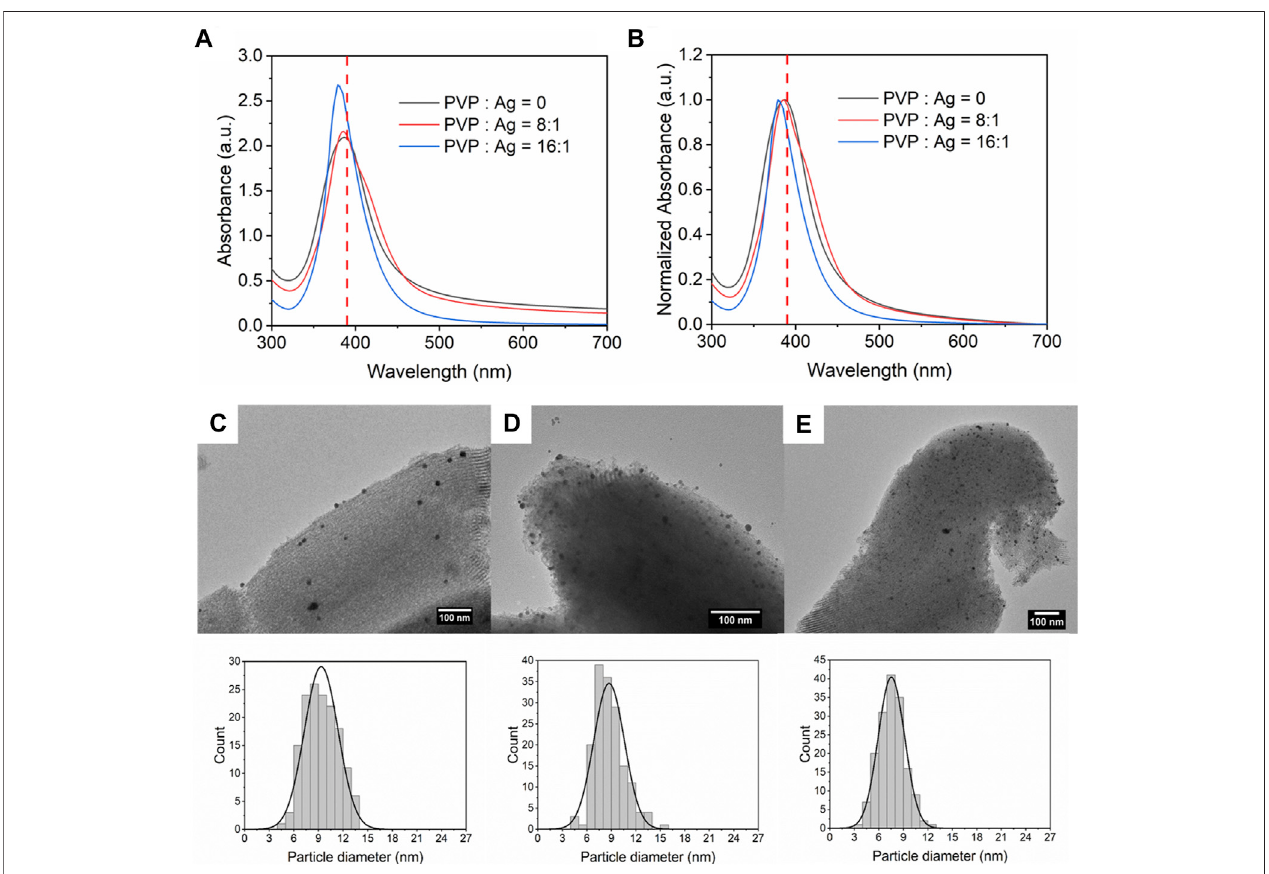
FIGURE 8 | (A) UV-Vis absorbance spectra and (B) normalized absorbance spectra for Ag/SBA-15 synthesized at different concentration ratio of PVP and silver nitrate.TEMimagesandsizedistribution ofsilvernanoparticlesdispersedonSBA-15synthesizedatPVPandAgNO